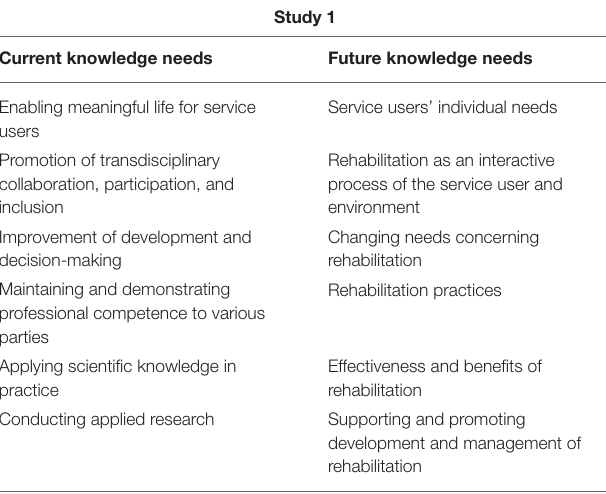
TABLE 2 | Summary of study